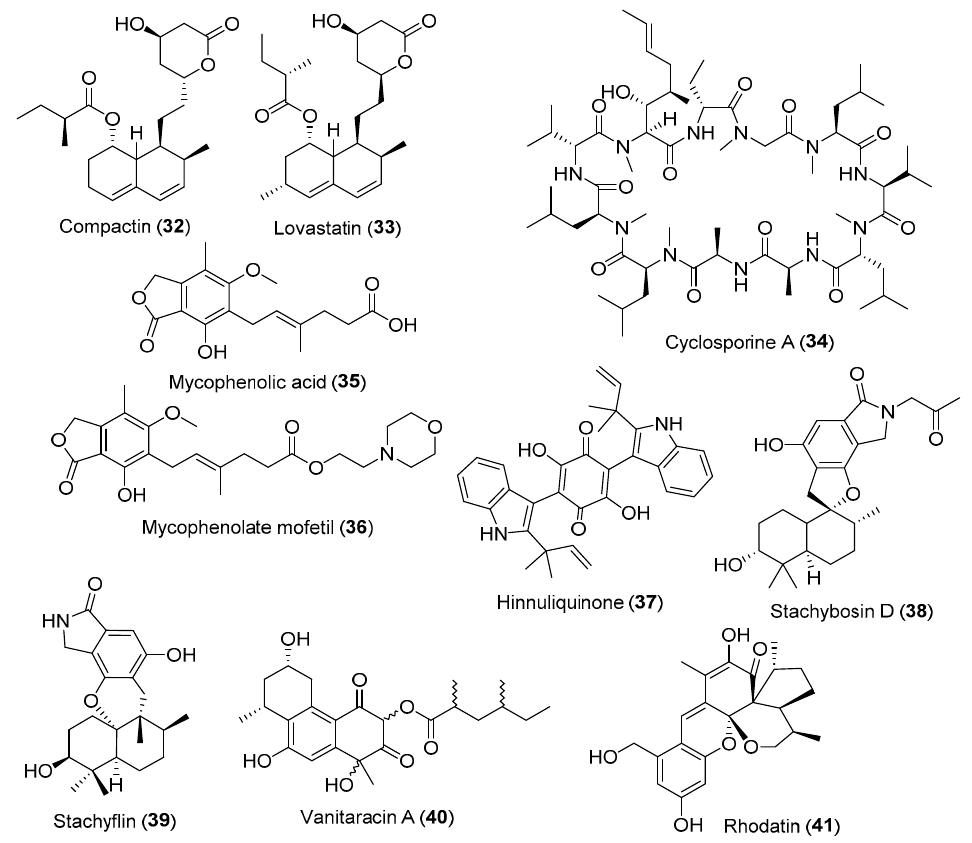
Figure 4. Selected fungal metabolites with antiviral, immunomodulatory and cardiovascular-related effects.